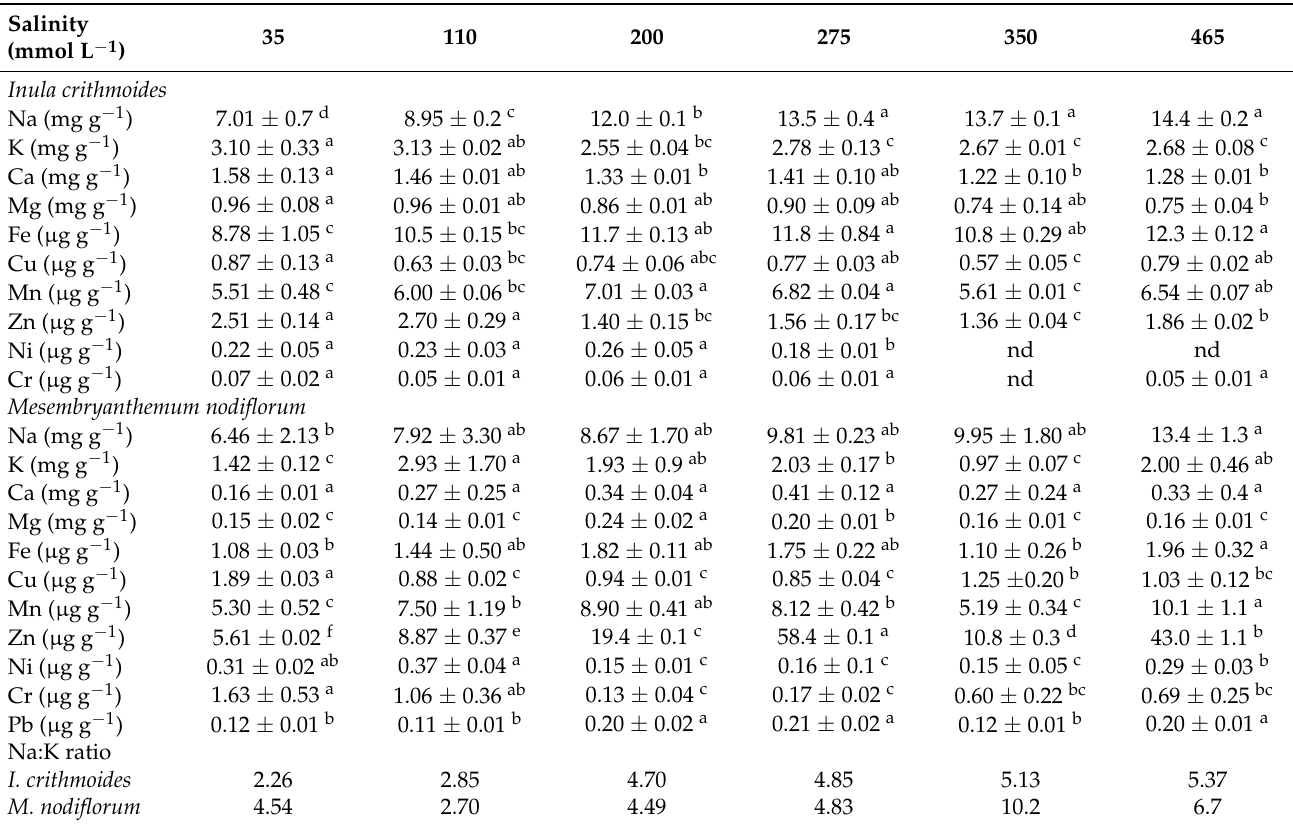
Table 2. Mineral composition of I. crithmoides and M. nodiflorum cultivated at six different